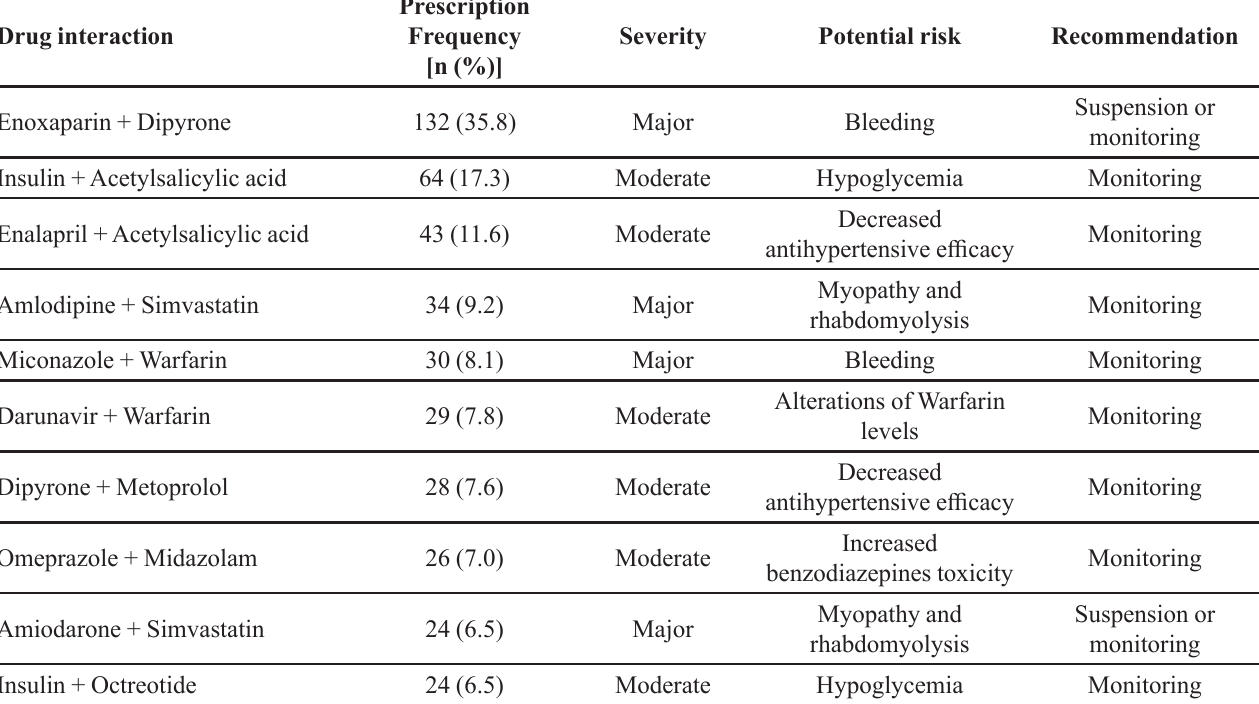
TABLE III - Most frequent relevant potential Drug-Drug Interactions